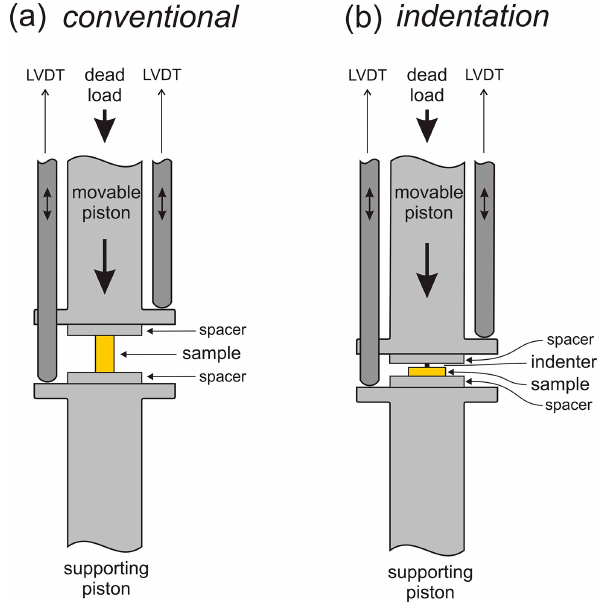
Figure 3. Scheme showing orientation of indenter axis with respect to foliation and lineation of the starting material, which shows CPO of [001] (cf. Fig. 1) parallel to lineation. Thin sections of experi- mentally deformed samples including the indenter are oriented nor- mal to lineation.